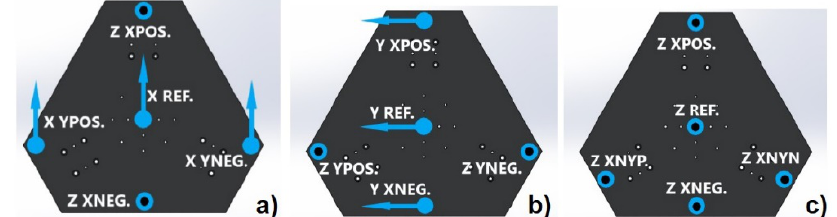
Figure 3. Position and sensing direction of the accelerometers on the moving platform of the delta shaker for the performance tests along X direction ( a ), Y direction ( b ) and Z direction ( c ).